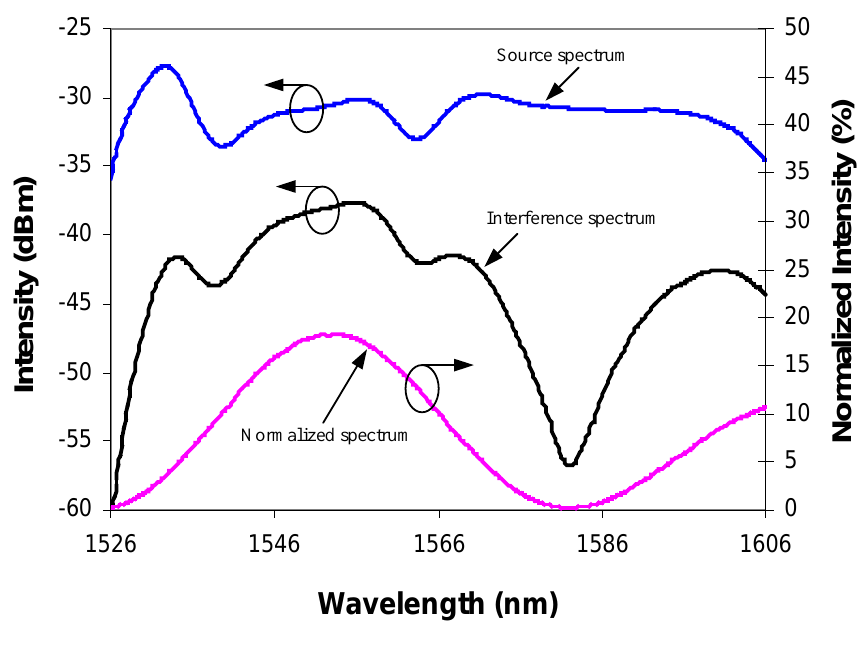
Figure 4. Source spectrum, interference spectrum, and normalized interference